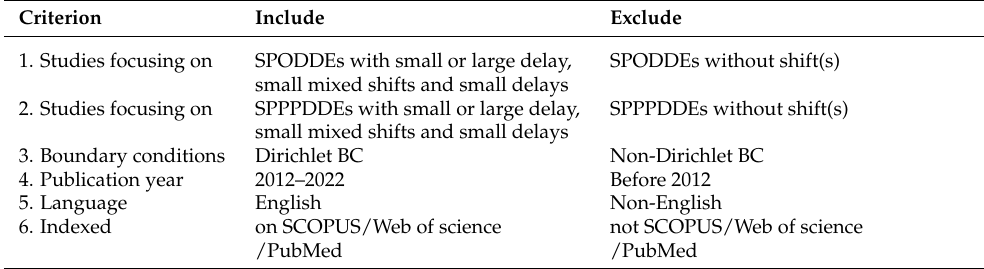
Figure 1. Review inclusion flowchart. Table 1. Inclusion and exclusion criteria of studies included in the